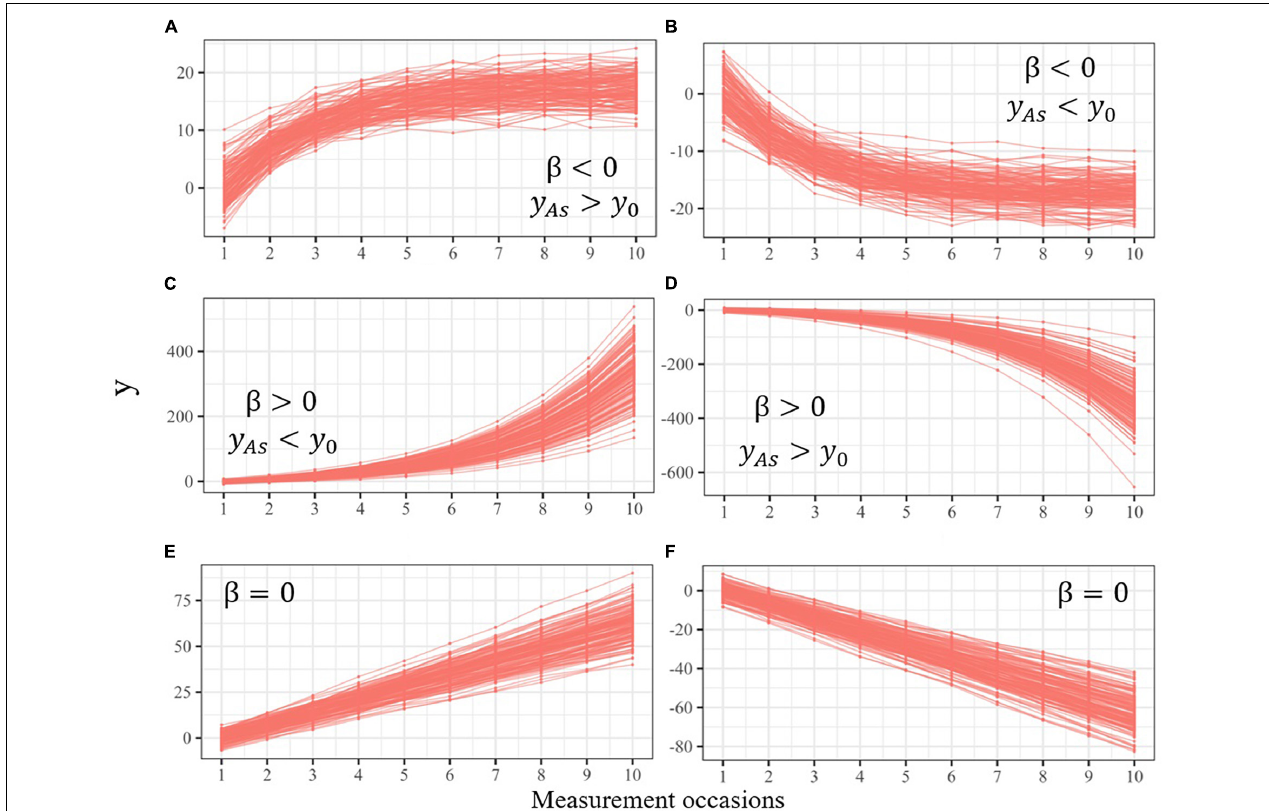
FIGURE 3 | Individual implied trajectories from a univariate LCS model with self-feedbacks of varying sign. Self-feedbacks are negative (A,B) , positive (C,D) , or zero (E,F) , indicating decelerated, accelerated, or linear change,